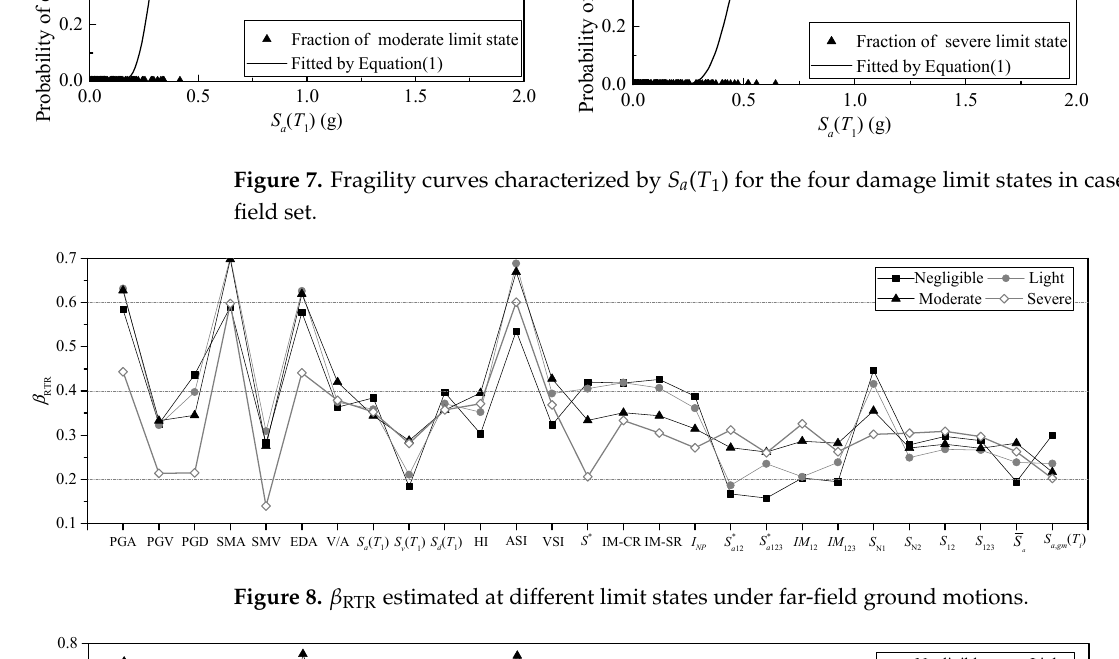
Figure 7. Fragility curves characterized by S a ( T 1 ) for the four damage limit states in cases of near- field set.